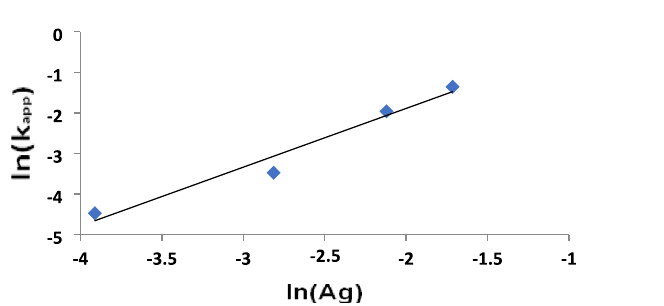
Figure 10. Plot of ln k app (min −1 ) versus ln [Ag] for photocatalytic degradation of the textile